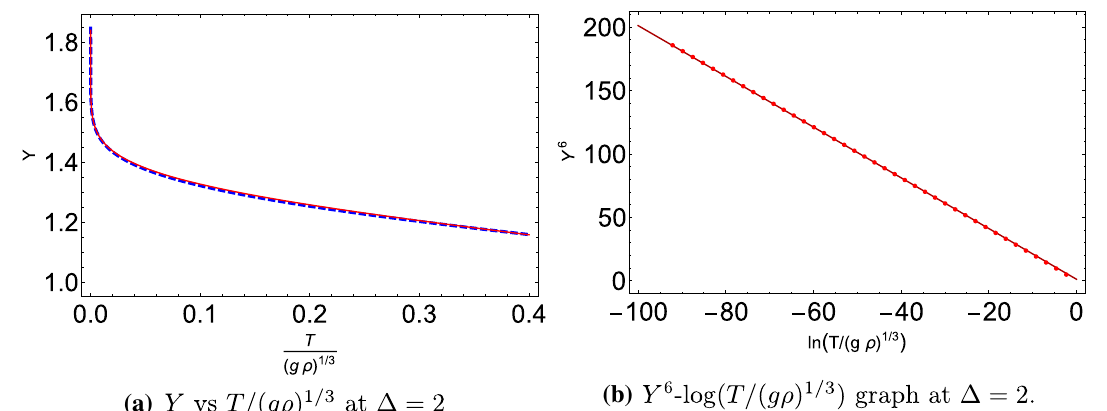
Fig. 26 a Y vs T /( g ρ) 1 / 3 : red colored curves for Y is a plot of Eq. (B.58). And blue dashed curves is a plot of Eq. (B.59). These two curves are almost identical for low temperature. b Y 6 -log ( T /( g ρ) 1 / 3 ) graph at (cid:2) = 2: The slope of red dotted line for Y 6 is − 2